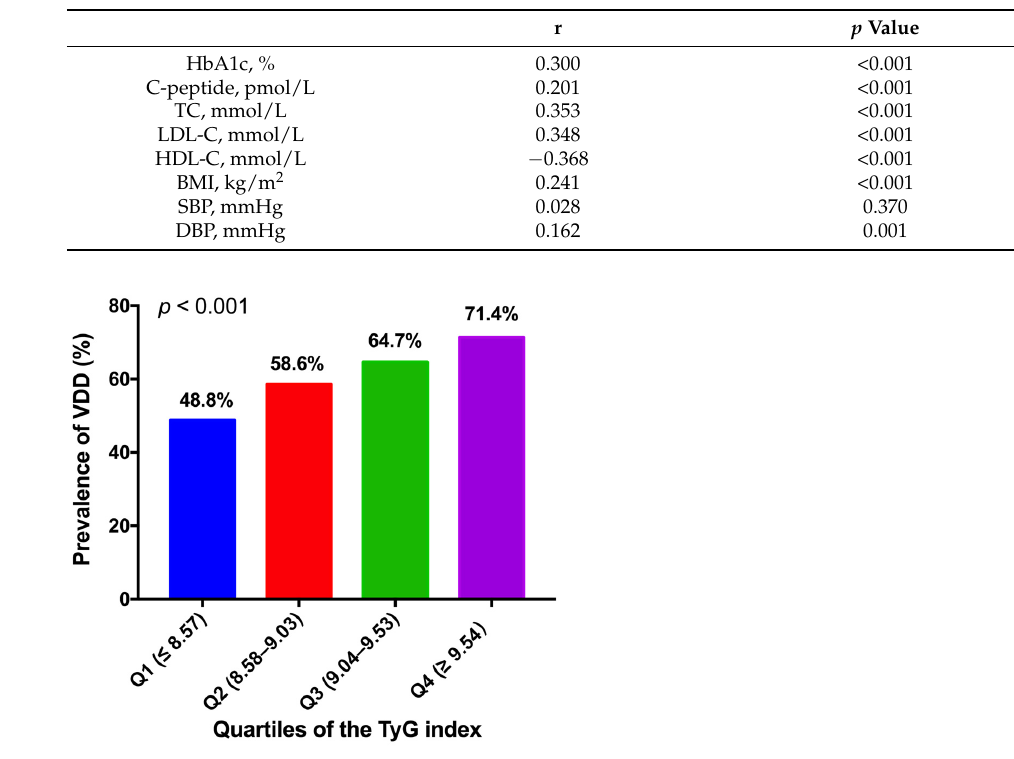
Table 2. Spearman’s correlation between TyG index and glycolipid-metabolic risk factors.